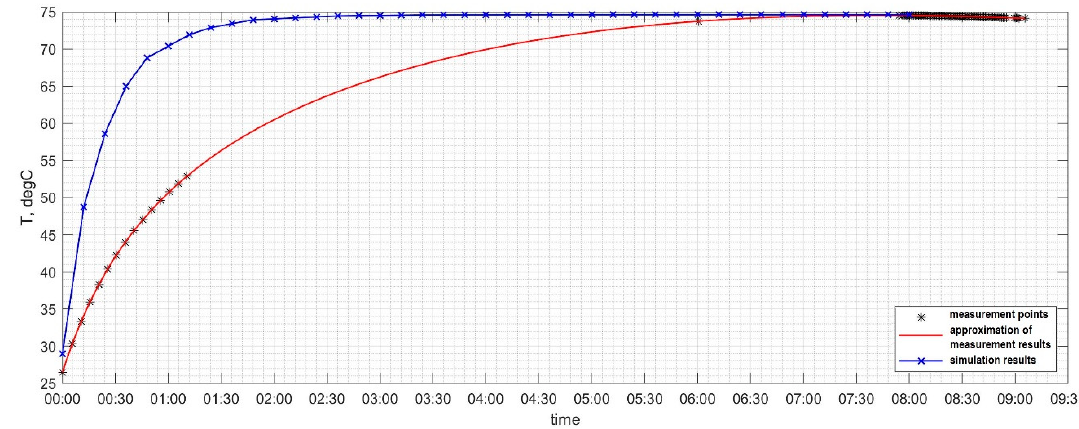
Figure 6. Results of measurements (in red) and simulation using the numerical model (in blue) gathered in the transient state during the heating process.